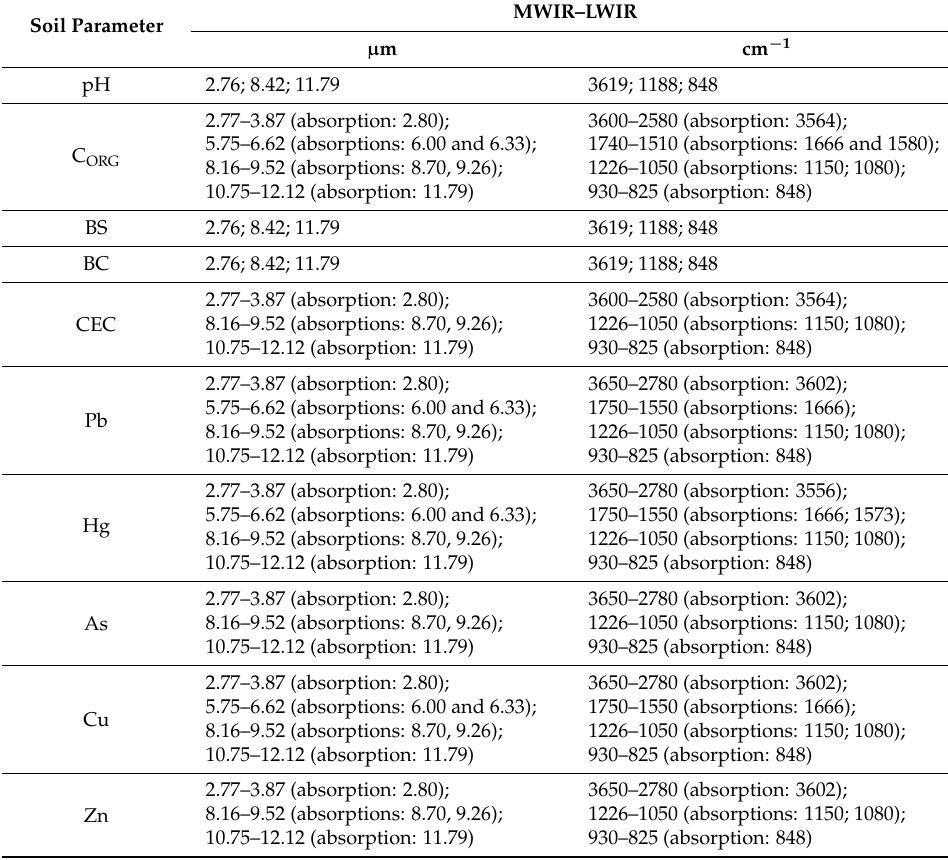
Table 9. Key wavelength ranges within MWIR–LWIR identified in this study employing a sensitivity analysis. As the results published by the scientific community commonly use the wavelength (µm) and/or wavenumber (cm − 1 ) scales, both scales are used to make the results comparable and universal.